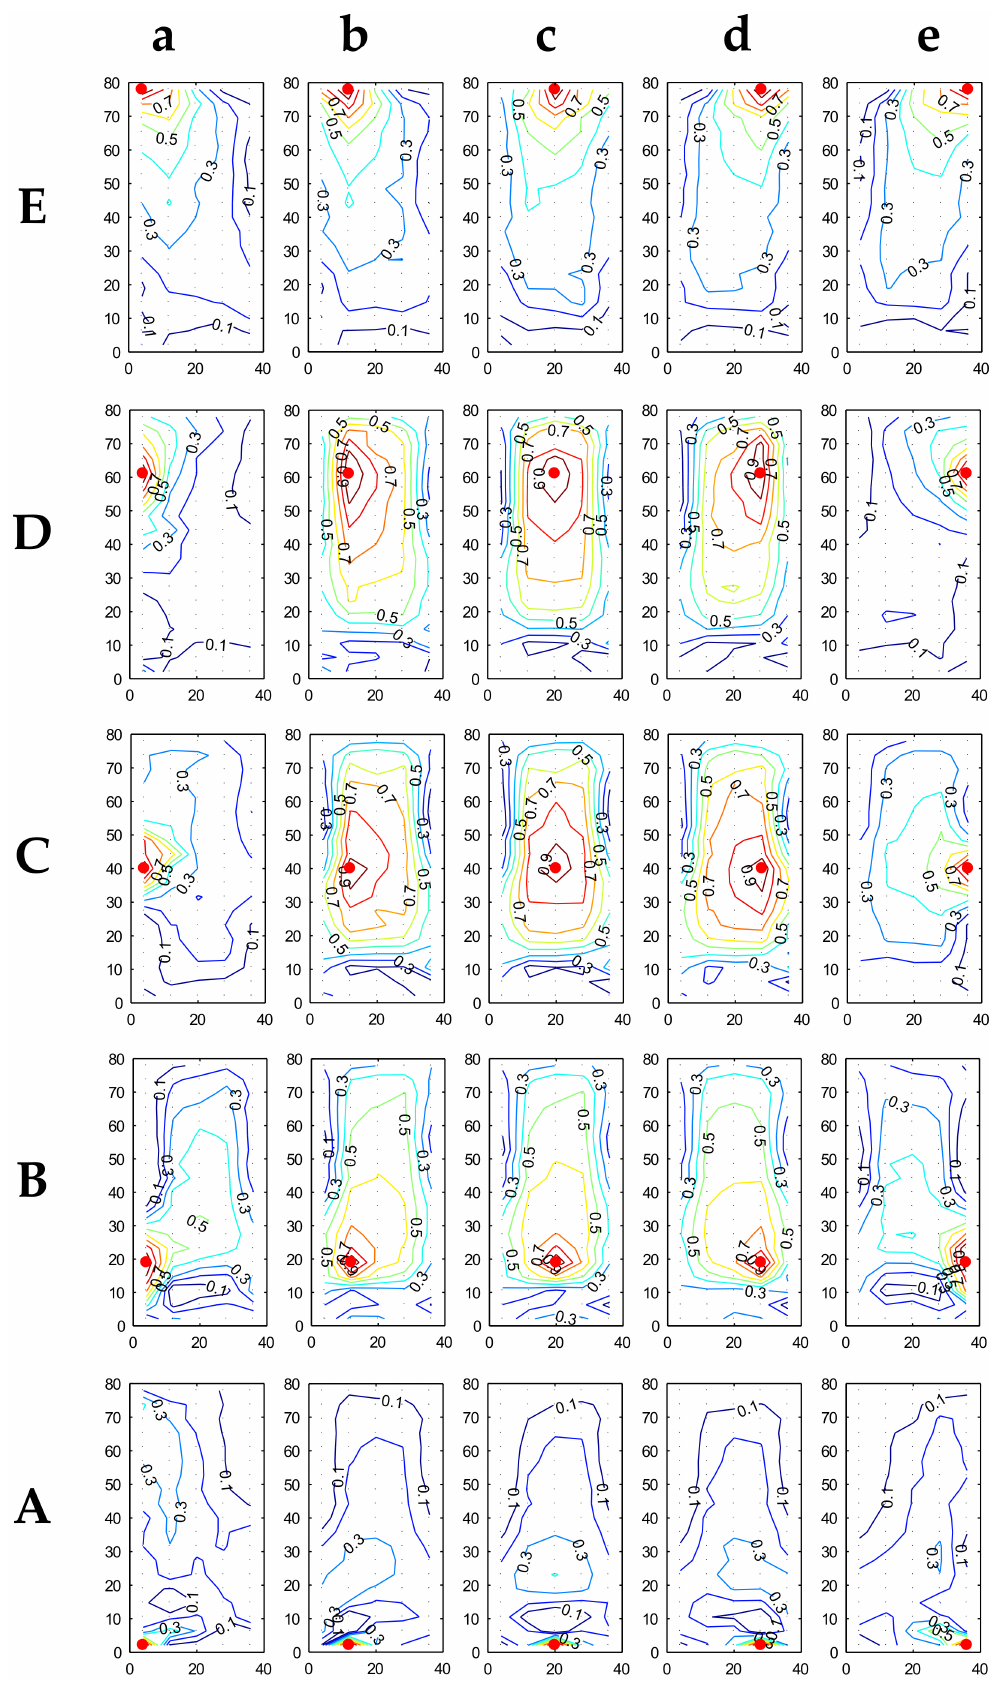
Figure 8. Correlation coefficient trend for RHF at 0 ◦ . Color bar as in Figure